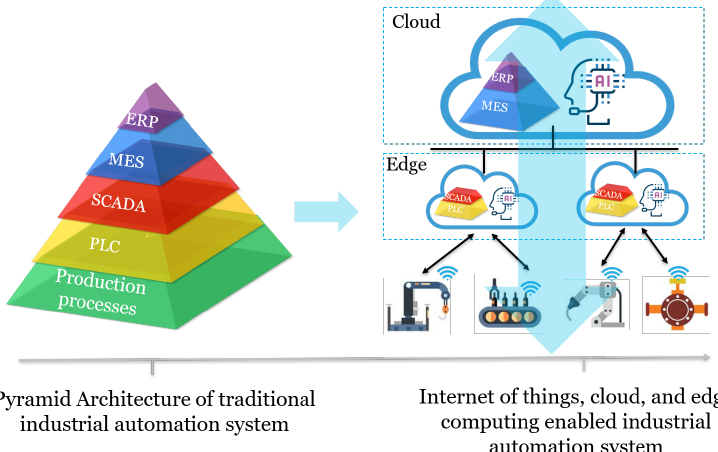
Figure 1. An illustration of the digital transformation in industrial automation system. The tradi- tional industrial automation system adopts a pyramid architecture where the production process, programmable logic controller (PLC), supervisory control and data acquisition (SCADA), manufac- turing execution system (MES), and enterprise resource planning (ERP) layers are strictly hierarchical. By leveraging IoT and cloud computing, the connectivity and computation capabilities are enhanced, and artificial intelligence derived from data is distributed across the full stack of the